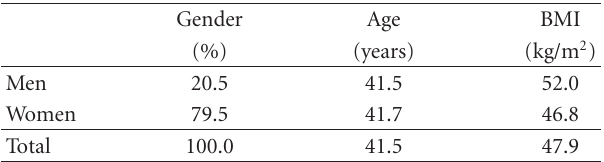
Table 1: Demographic data.